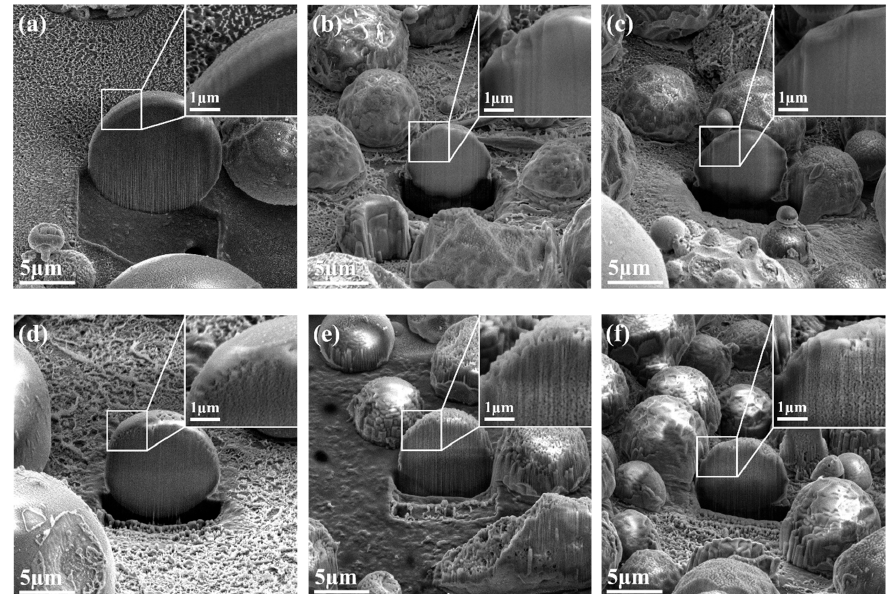
Figure 3. SEM images of focused ion beam (FIB)-prepared cross section particles showing solid and porous structure of ( a , d ) 58S; ( b , e ) 68S; and ( c , f ) 76S BG powders with insets of their inner structure captured at higher